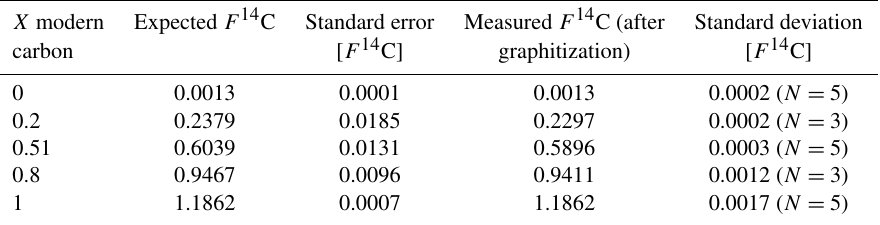
Table 1. Analyses of mixtures of SRM 2975 and SRM 1515 standards in the form of solid graphite targets of large samples (roughly 1mgC). X modern carbon represents the mass fraction of modern carbon; see Eq. (5). The mass fraction of each SRM can be calculated using their carbon content (i.e., 45% for SRM1 515 and 78% for SRM 2975). “Expected F 14 C” is calculated by using the mass of each SRM and its measured F 14 C as end-members. Measurements are made with solid target (graphitization, roughly 1mgC).